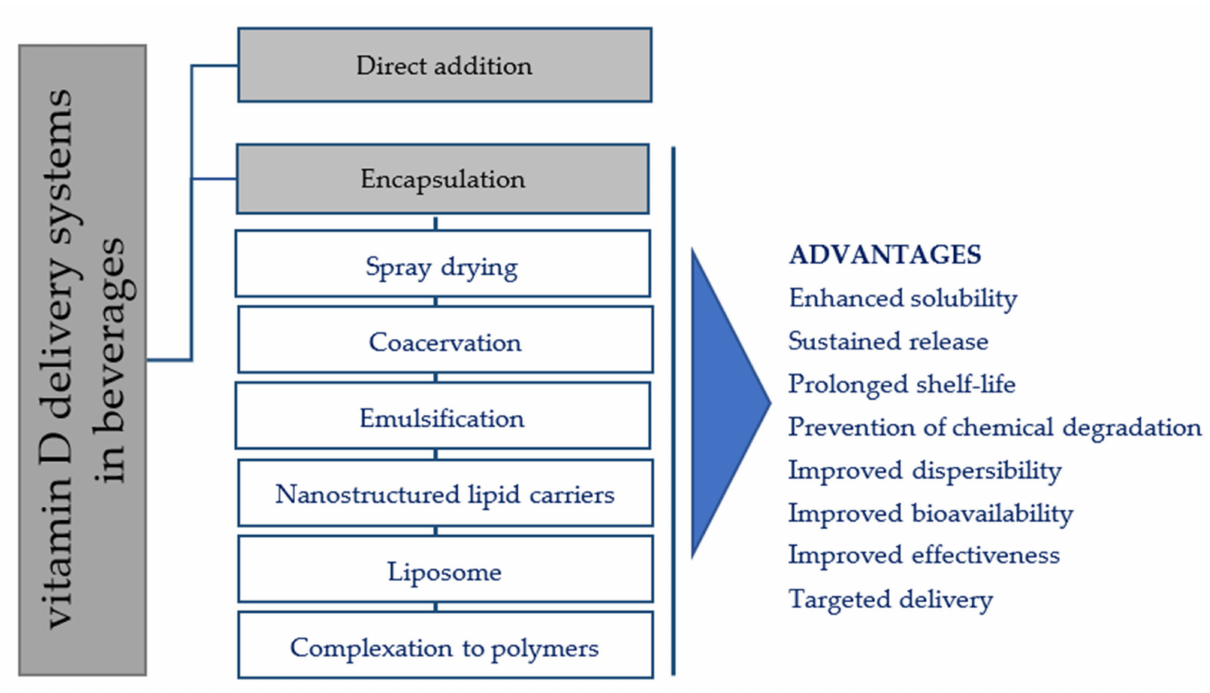
Figure 2. An illustration of various vitamin D delivery approaches used to fortify